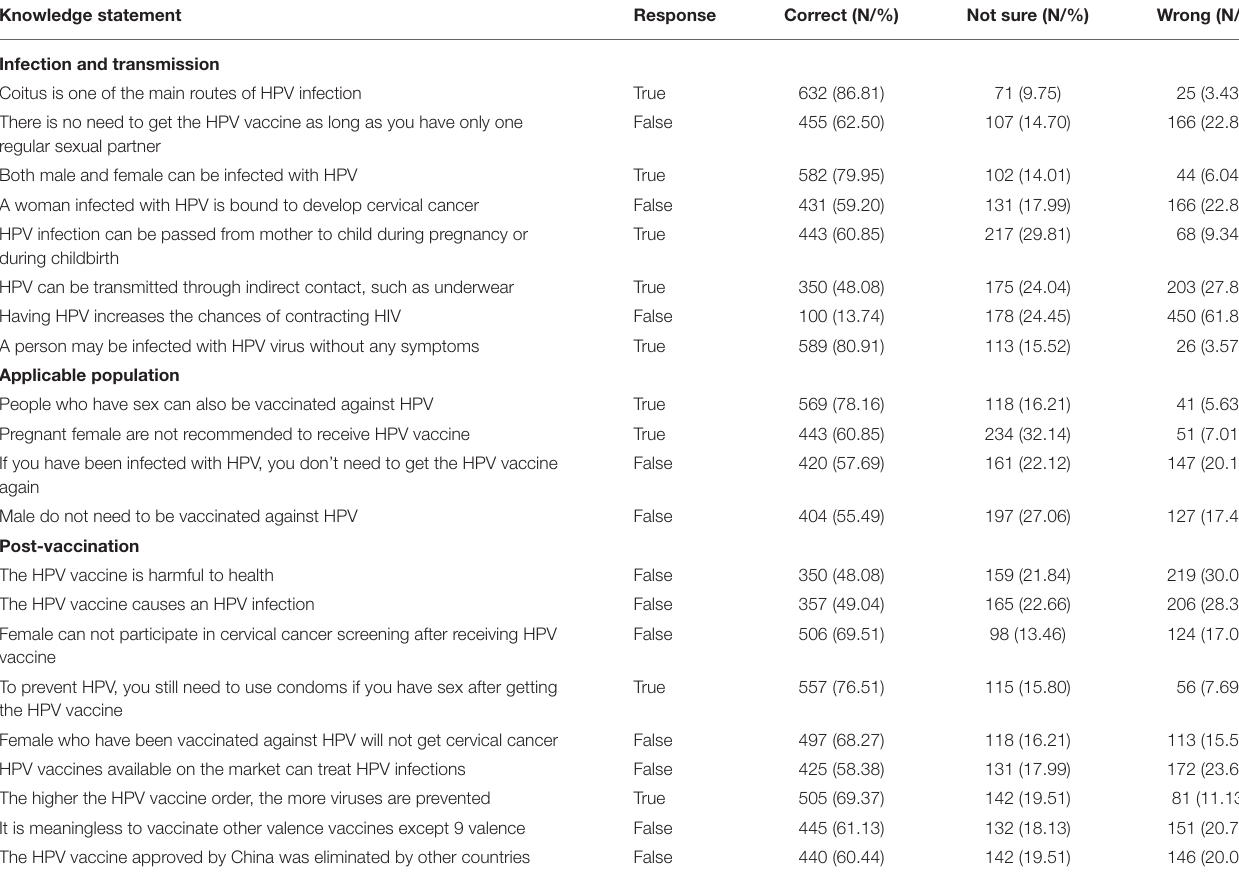
TABLE 2 | Respondents’ HPV cognitive list.